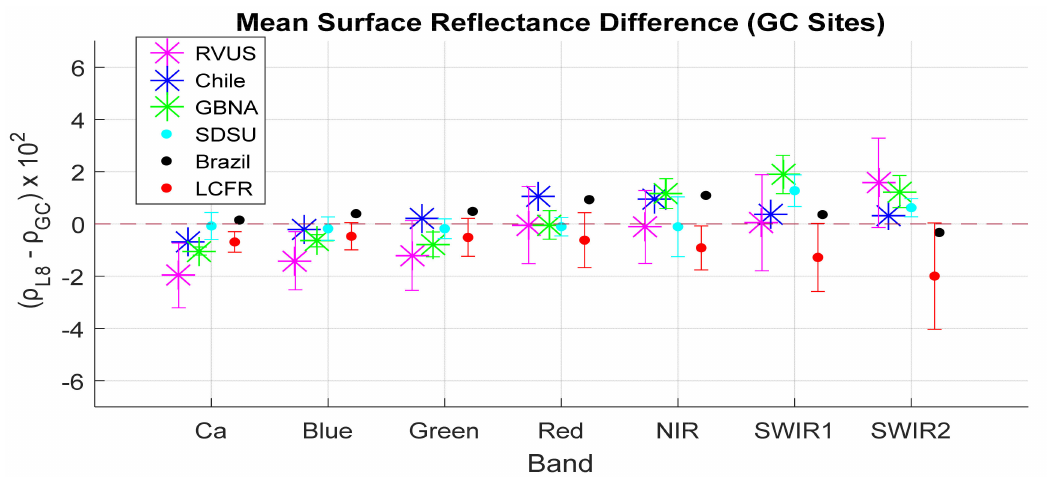
Figure 16. Mean reflectance difference between OLI and ground truth measurements. Bright cover sites are represented with a ‘ ✳ ’ and vegetation cover sites are represented with a ‘•’. Sites with no error bars only have one coincident overpass with Landsat8.